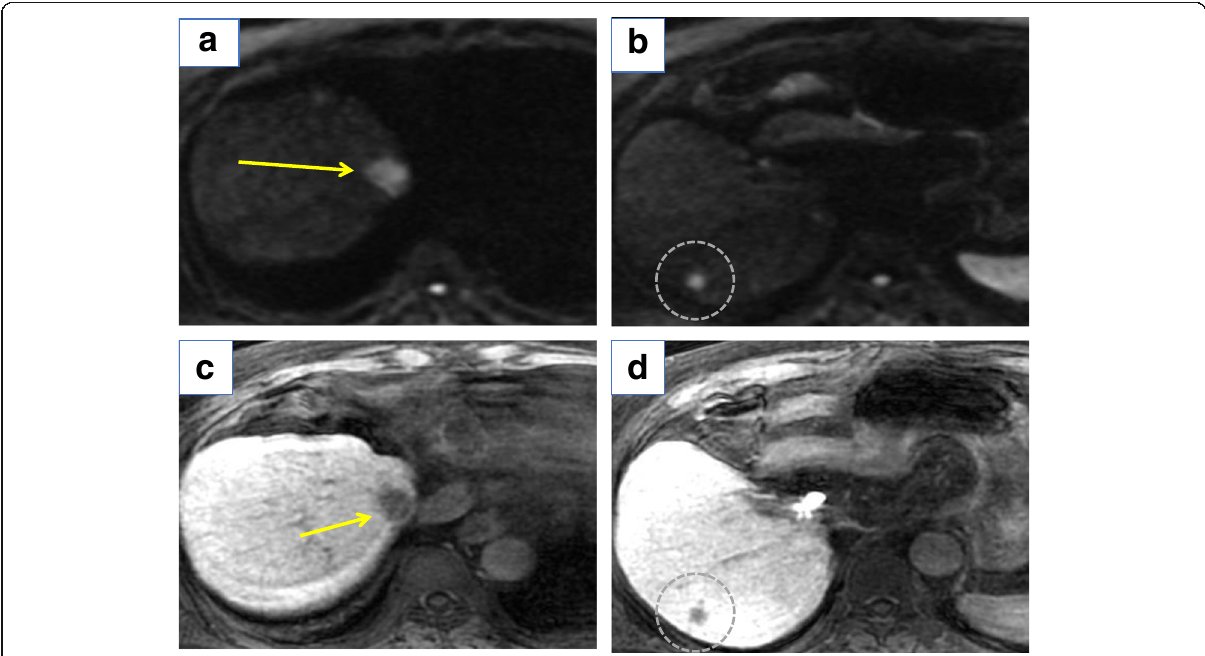
Fig. 2 Gd-EOB-DTPA-enhanced MRI shows two lesions, one each in segments 7 and 8. a, b Diffusion-weighted imaging showing high-intensity lesions. c , d Gd-EOB-DTPA-enhanced MRI shows low-intensity lesions in the hepatocellular